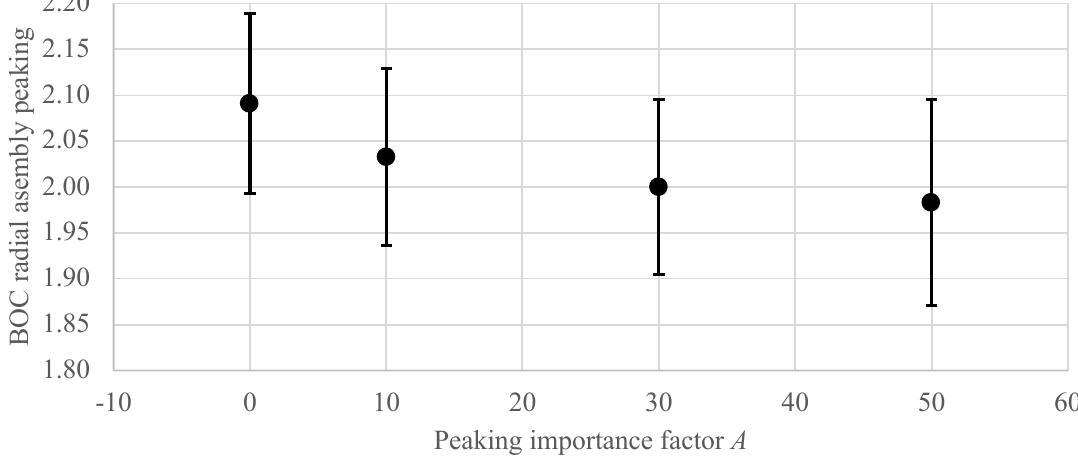
Figure 1 . Average core radial peaking factor at